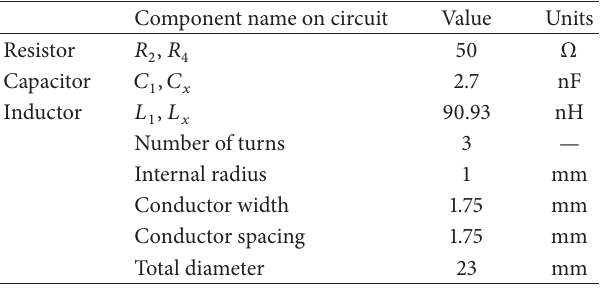
Figure 10: Voltage variations on reader coil versus distance. Trans- mission medium between coils: air.